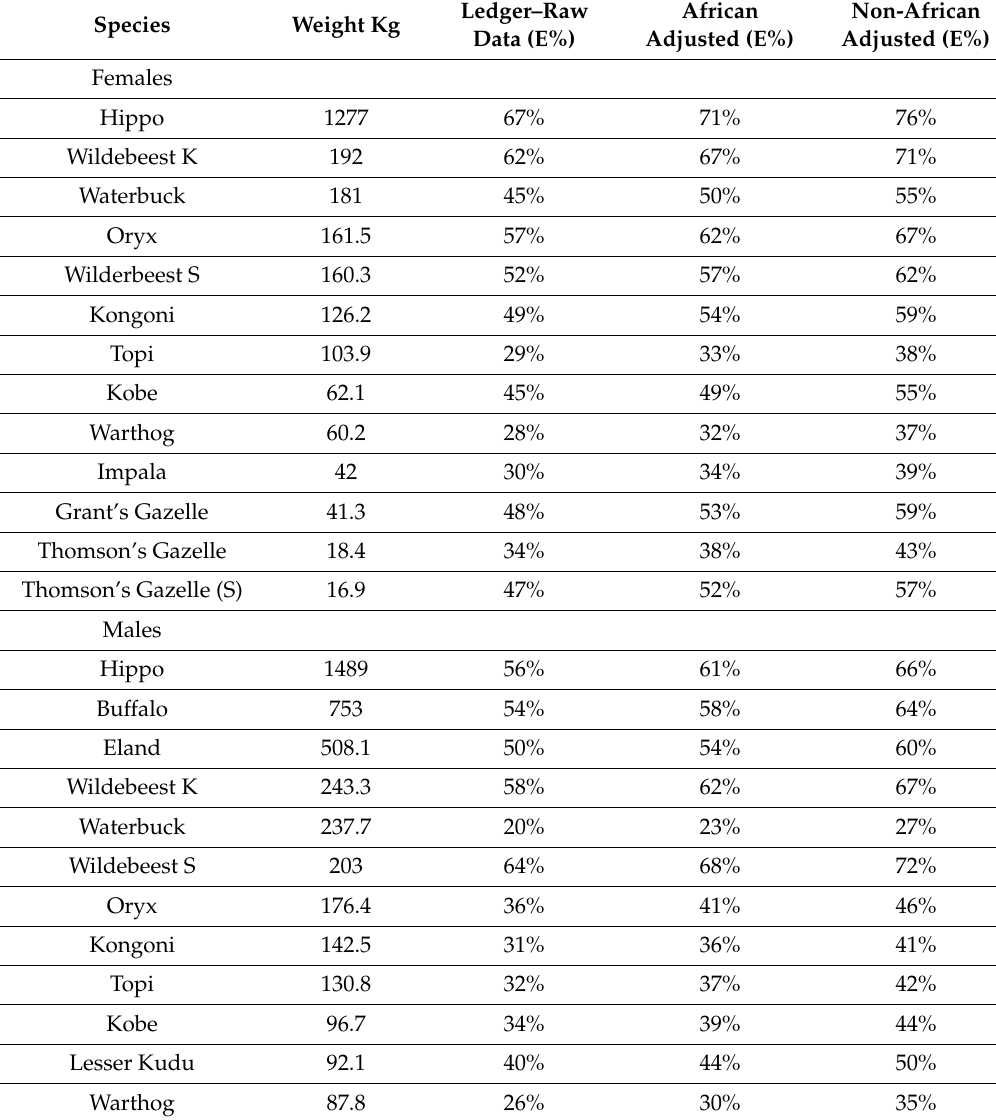
Ledger–Raw African Non-African Data (E%) Adjusted (E%) Adjusted (E%)